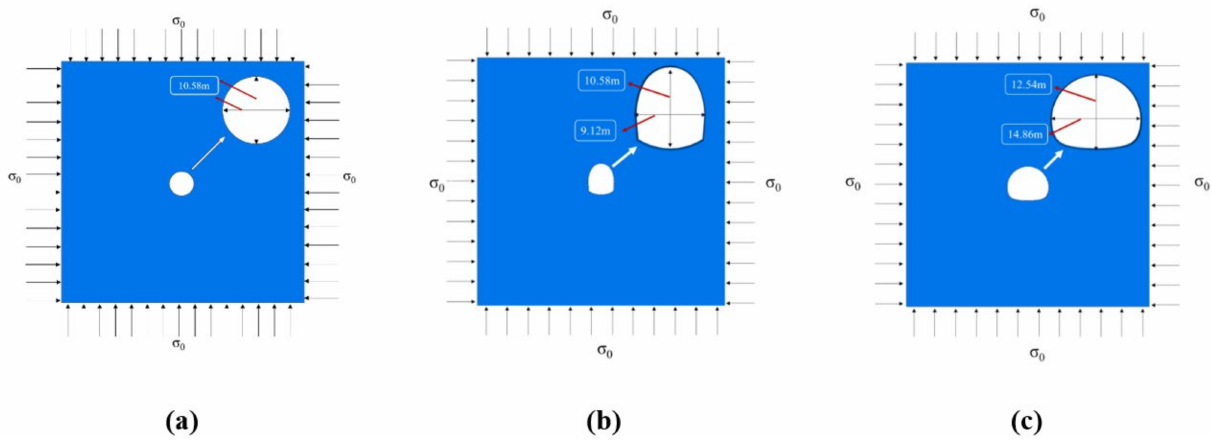
Figure 6. Numerical calculation model: ( a ) Circular; ( b ) Single-track; ( c ) Double-track. Considering in-situ stress, section type, and lateral pressure coefficient, 18 working conditions are combined. The specific calculation conditions are listed in Table 5, and the numerical calculation parameters are shown in Table